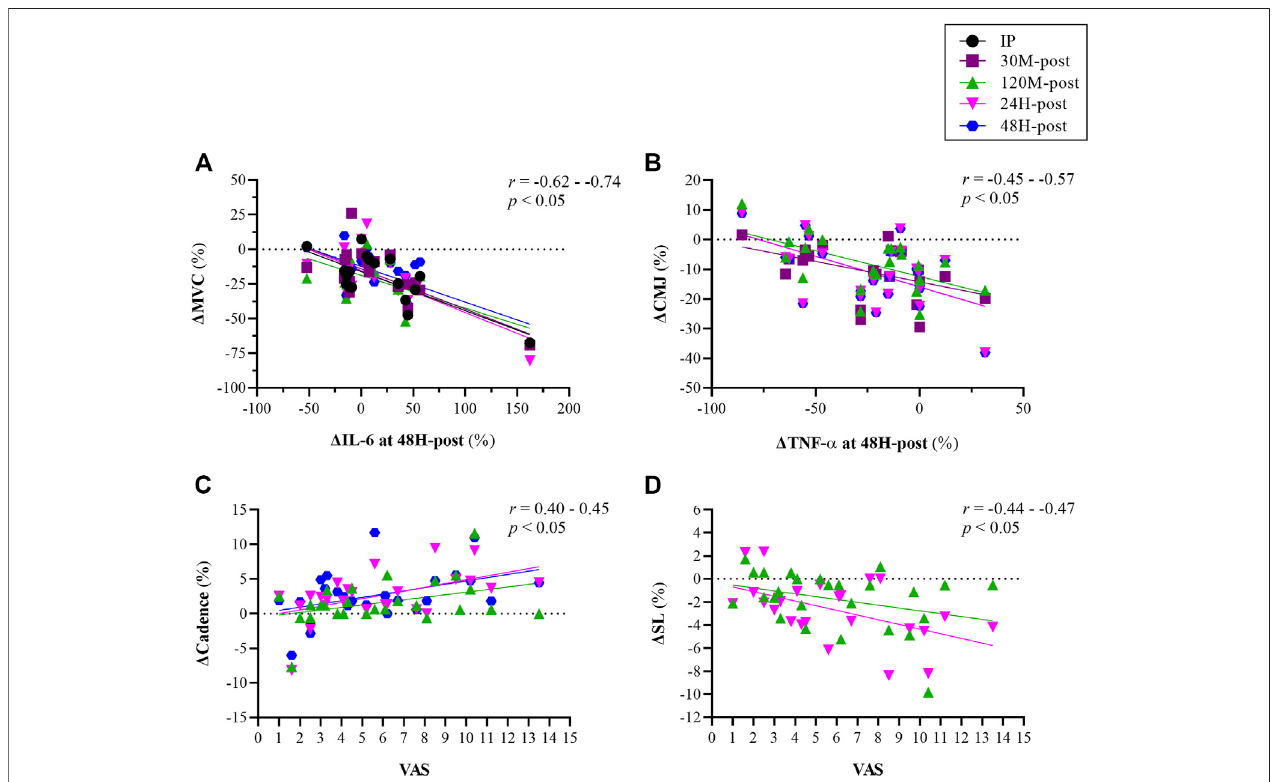
FIGURE7| Correlationsbetweenchangesinin fl ammatory/biochemicalmarkers[interleukin(IL)-6,Tumornecrosisfactor- α (TNF- α )]andchangesforceproduction at various time pointsrelativetobaseline [panels (A,B) ],and betweensubjectiveperception ofpainmeasured assessed usingavisualanalog scale(VAS;15-pointscale) and changes in biomechanicalindices [cadence panel (C) ; stride length (SL) panel (D) ] at various time points relative to baseline. Measurements were taken asbaseline, immediately post (IP), 30 min (30 M), 120 min (120 M), 24 h (24H) and 48 h (48H) following a 60 min downhill running protocol. Each color represents corrolation between two variables at given time point (see legend for details).